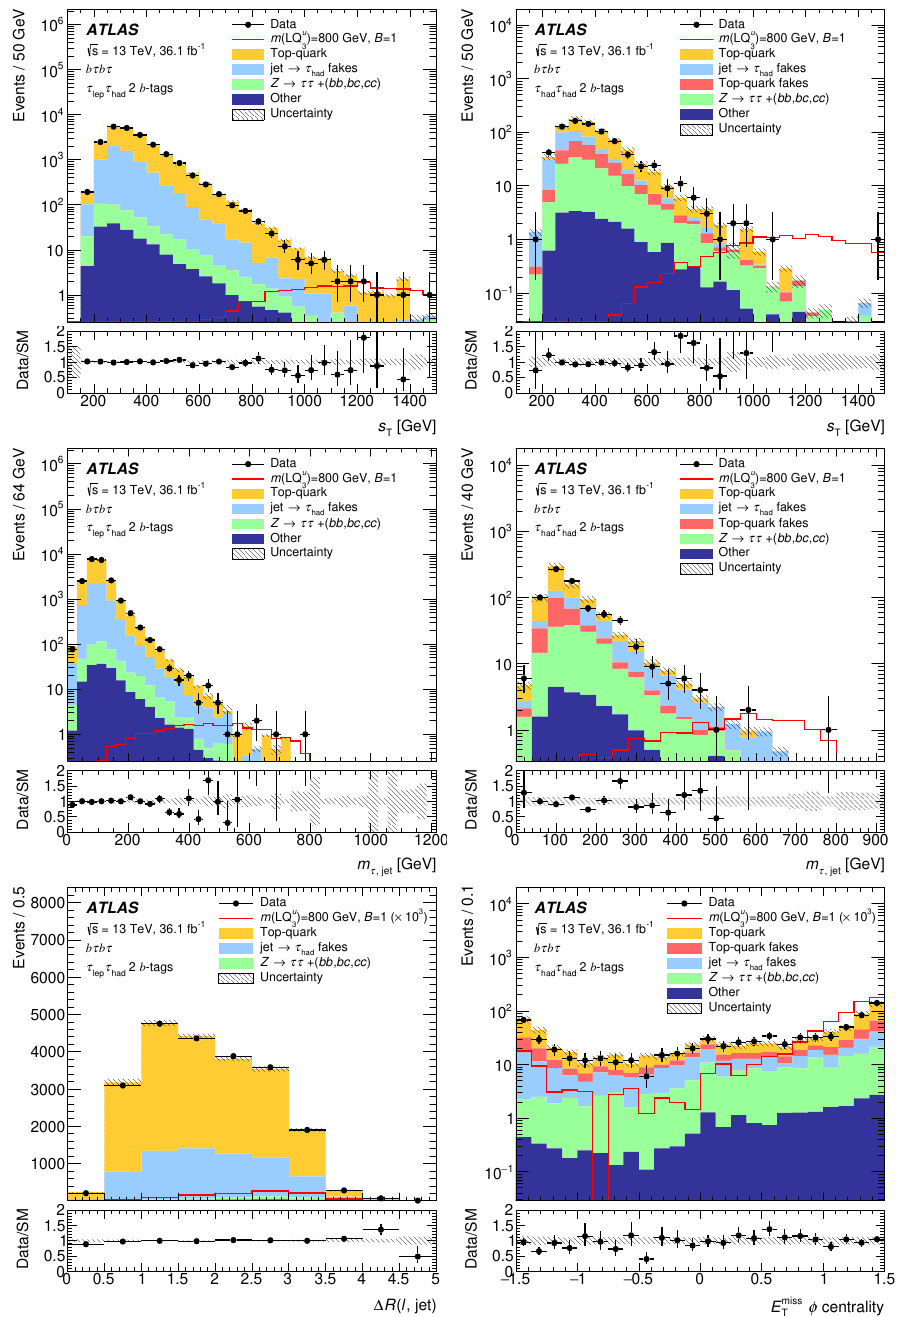
Figure 4 . Kinematic distributions for (cid:28) ‘ (cid:28) had (left) and (cid:28) had (cid:28) had (right) signal regions in 2-tag events after performing the combined channel (cid:12)t. The ratio of the data to the sum of the backgrounds is shown in the lower panel. The hatched bands indicate the combined statistical and systematic uncertainties in the background. Distributions include the scalar sum of transverse momentum of reconstructed objects in the event ( s T ), the invariant mass between the leading (cid:28) -lepton and its mass-paired jet ( m (cid:28); jet ), the invariant mass between the lepton and its matching jet from the mass-pairing strategy ( m ‘; jet ), the (cid:1) R between the leading (cid:28) -lepton and jet ((cid:1) R (lep ; jet)), and the E miss (cid:30) centrality, which quanti(cid:12)es the (cid:30) separation between the E miss and (cid:28) -lepton(s). T T